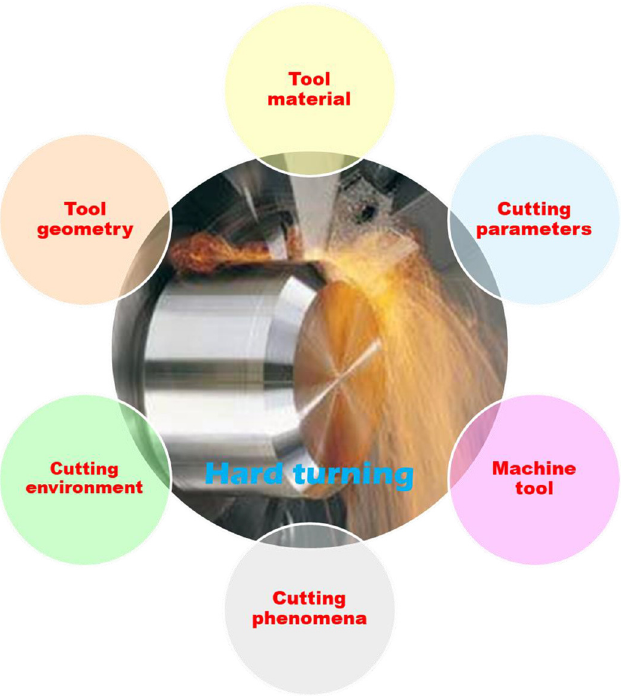
Fig. 3. In fl uence of different parameters on hard